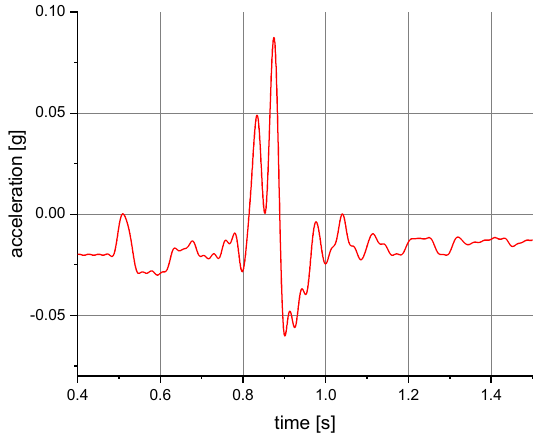
Figure 6. Acceleration as a function of time recorded during fall arrest. Test conditions: back point of the safety harness; the sensor mounted on the back of the manikin.